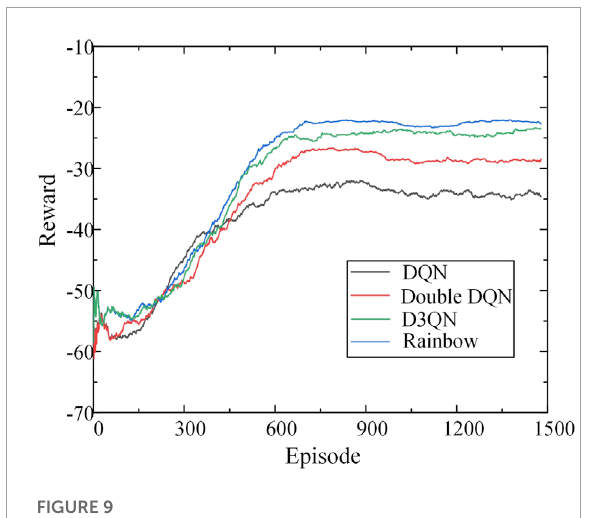
FIGURE 10 The distribution of reward values of different